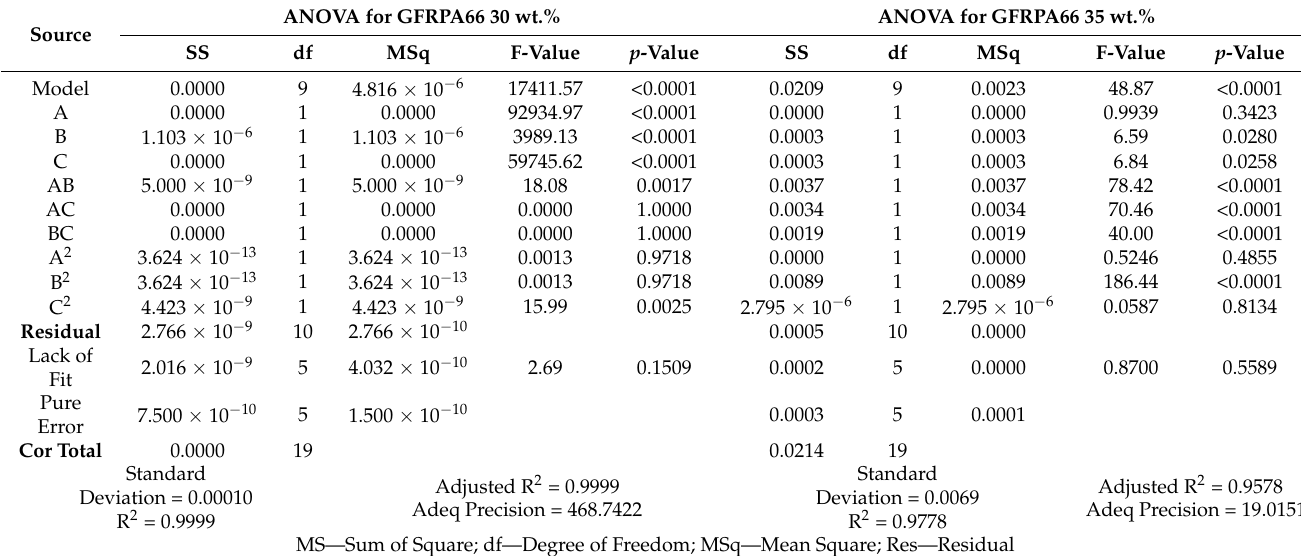
Table 3. ANOVA table of SWR for GFRPA66 30 wt.% and GFRPA66 35